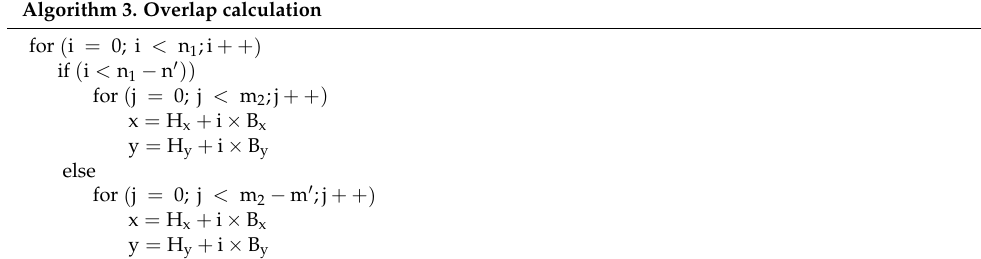
Algorithm 3. Overlap calculation